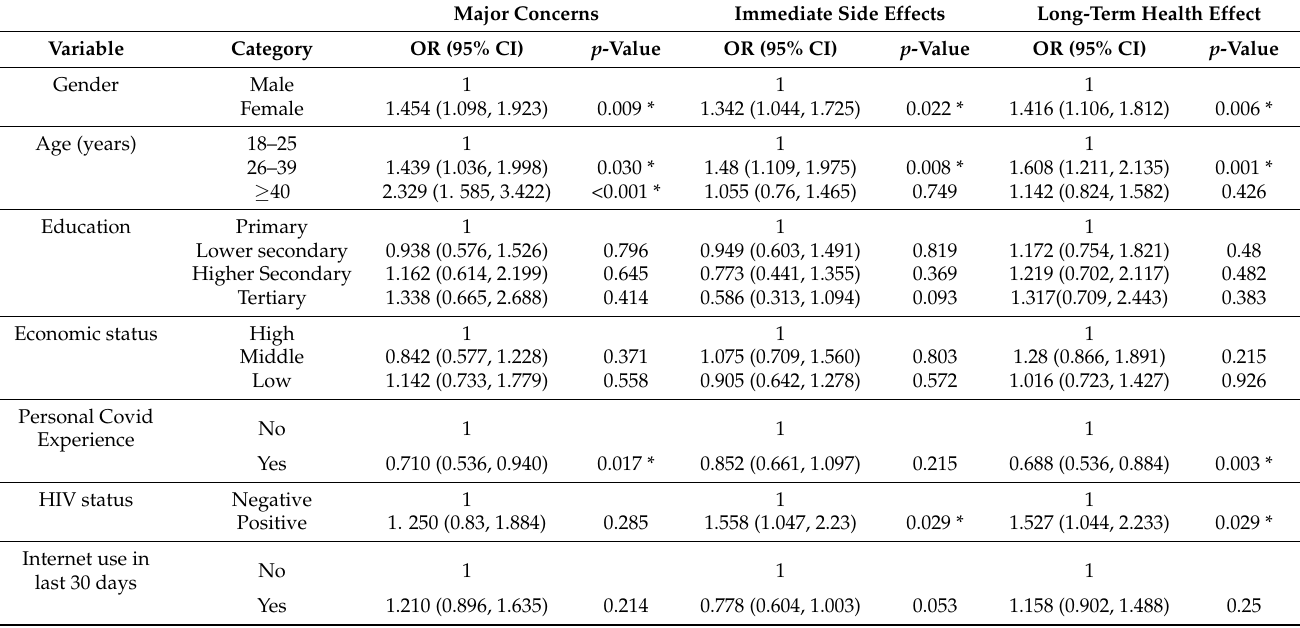
Table 3. Major concerns about COVID-19 vaccine, Immediate side effects and Long-term health